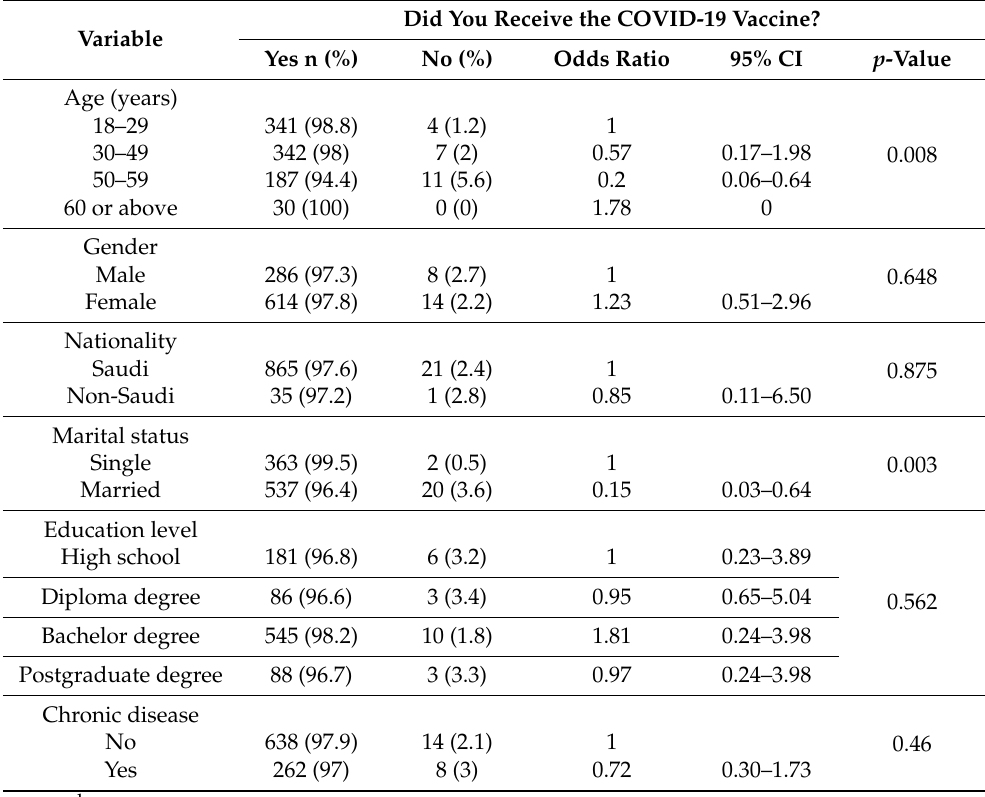
Table 3. Factors associated with the acceptance of the COVID-19 vaccine (n = 922).